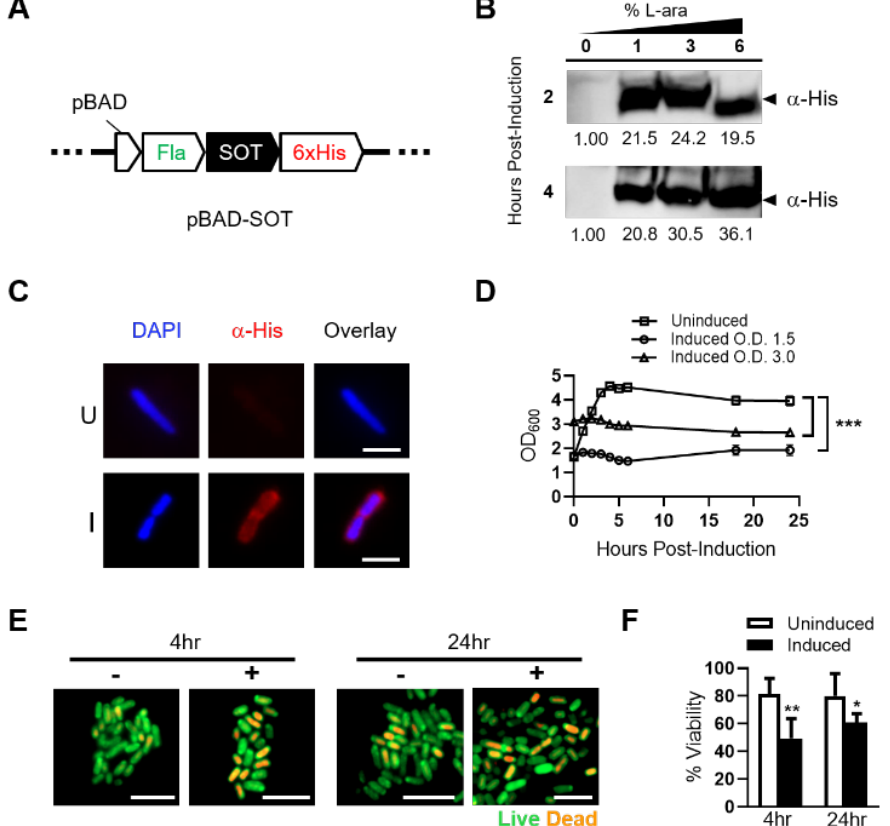
Figure 1. Expression, subcellular localization and toxicity of SOT in attenuated ST. ( A ) Schematic of inducible pBAD construct (pBAD-SOT) integrating ampicillin resistance with N-terminal flagellin (Fla) fusion and C-terminal 6XHis tag fusion to SOT for downstream analyses. ( B ) Attenuated ST transformed with the pBAD-SOT construct was cultured in Luria Broth (LB) containing 0% (uninduced) or 1–6% (induced) L-arabinose for up to 4 h at 37 ◦ C. Bacterial cell lysates from ~5 × 10 7 colony forming units (CFUs) at each time point for each L-arabinose concentration were run on a 4–20% polyacrylamide gradient gel and subjected to Western blot analysis against a His-tag fused to the C-terminus of SOT ( α -His). Predicted SOT fusion size ~31 kDa (arrow). Band densitometries are shown under blots relative to uninduced. ( C ) ST-SOT was cultured in LB media containing 2% L-arabinose for 1 h and then immunostained ( α -His) to determine subcellular localization of SOT (red). Nuclei are stained with DAPI (blue). Representative images shown. Scale bar = 10 µ